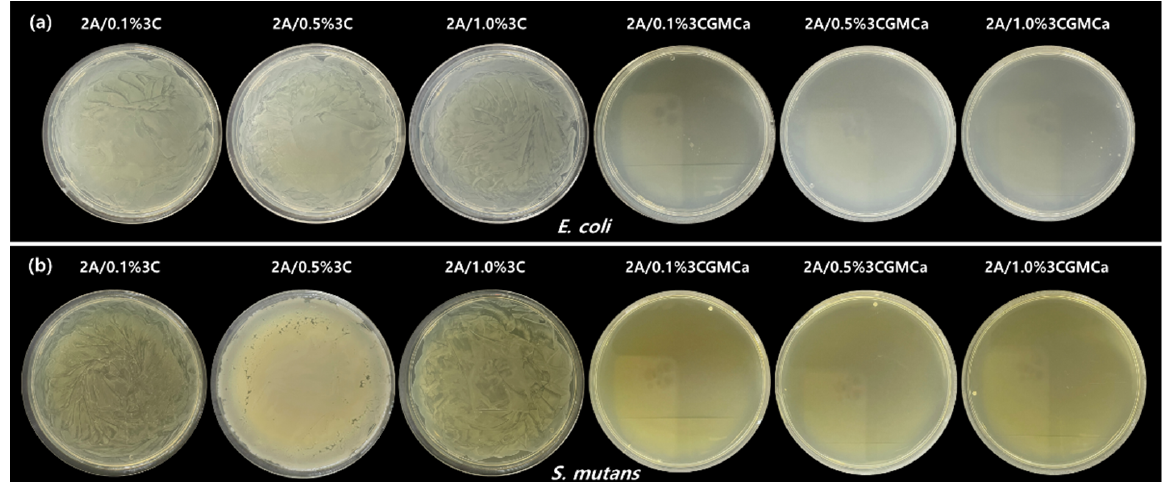
Figure 4. Assays were conducted against gram-negative E. coli ( a ) and gram-positive S. mutans ( b ). An antibacterial effect was observed in the agar plates inoculated with 100 μ L of supernatant PBS solution immersed with chitosan-alginate-gentamicin (2A/x%3CGMCa, x = 0.1, 0.5, 1.0) beads con-